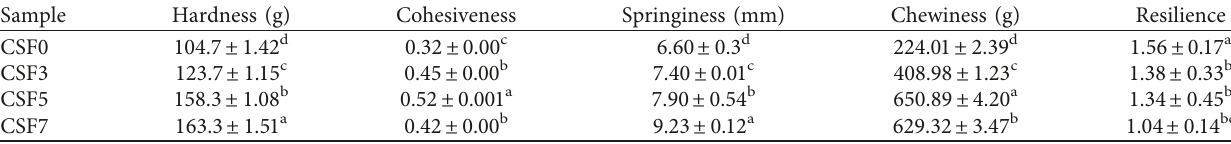
Table 5: Effect of replacing egg by chia seed flour (CSF) on texture profile parameters of